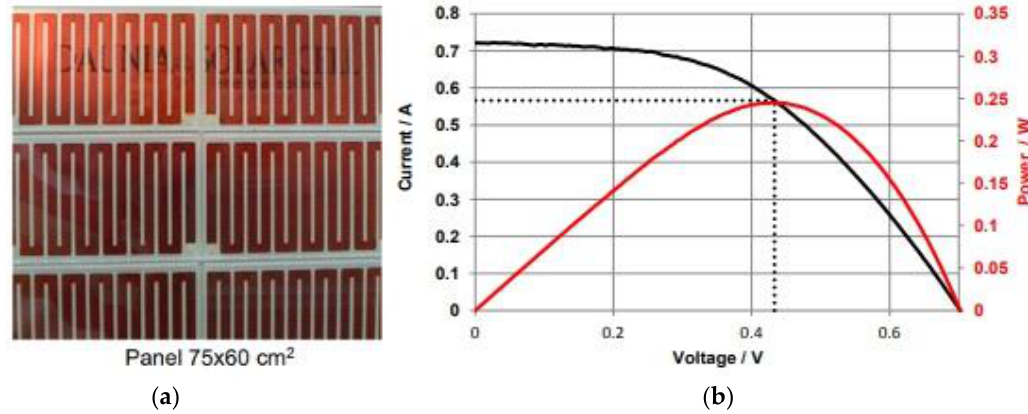
Figure 8. Experimental data from Daunia solar cell prototypes, Tozzi Renewable Energy, TRE. DSSC module (area 150 cm 2 ) with 3% efficiency at one sun: ( a ) prototype; ( b ) graph of current and power vs voltage.